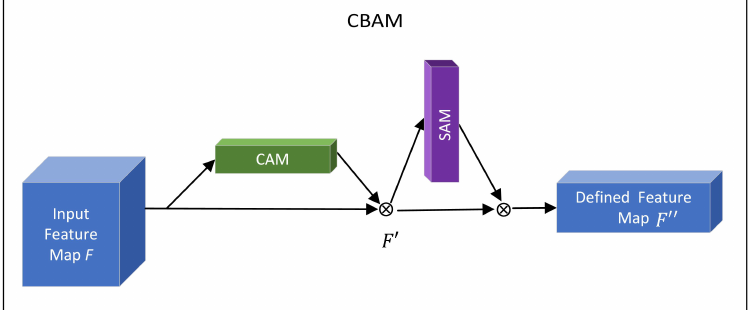
Figure 2. Relationship between CBAM and CAM, SAM